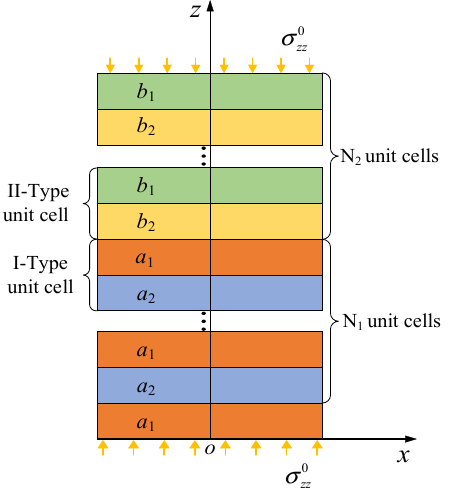
Figure 2. ( a ) I–type unit cell with thickness a and ( b ) II–type unit cell with thickness b .